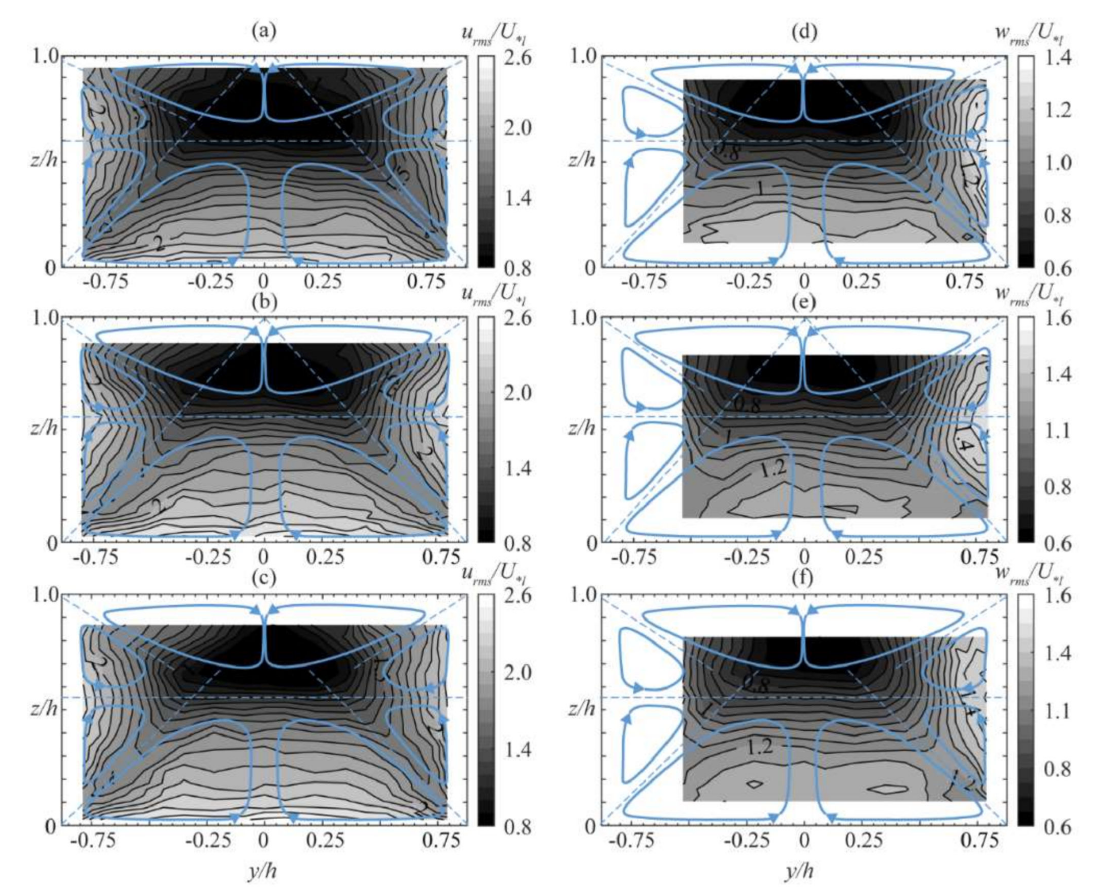
Figure 6. Contour plots of turbulence intensities in ( a – c ) streamwise direction, ( d – f ) vertical direction for